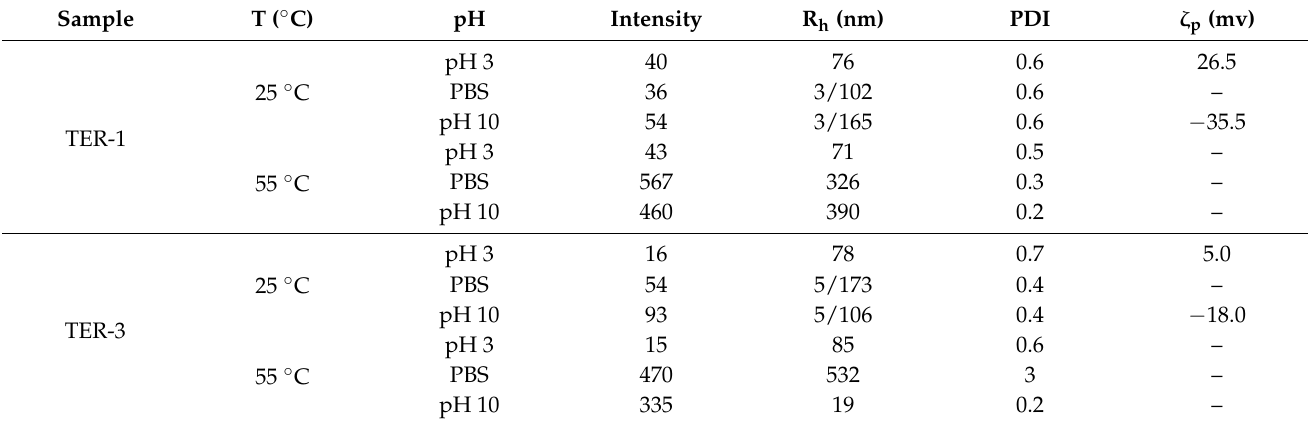
Figure 7. Scattering intensity (I) and the hydrodynamic radius (R h ) as a function of temperature at ( a ) pH = 3, ( b ) PBS and ( c ) pH = 10 for TER-3 terpolymer. Table 2. Structural characteristics of TER-1 and TER-3 terpolymers in aqueous media.